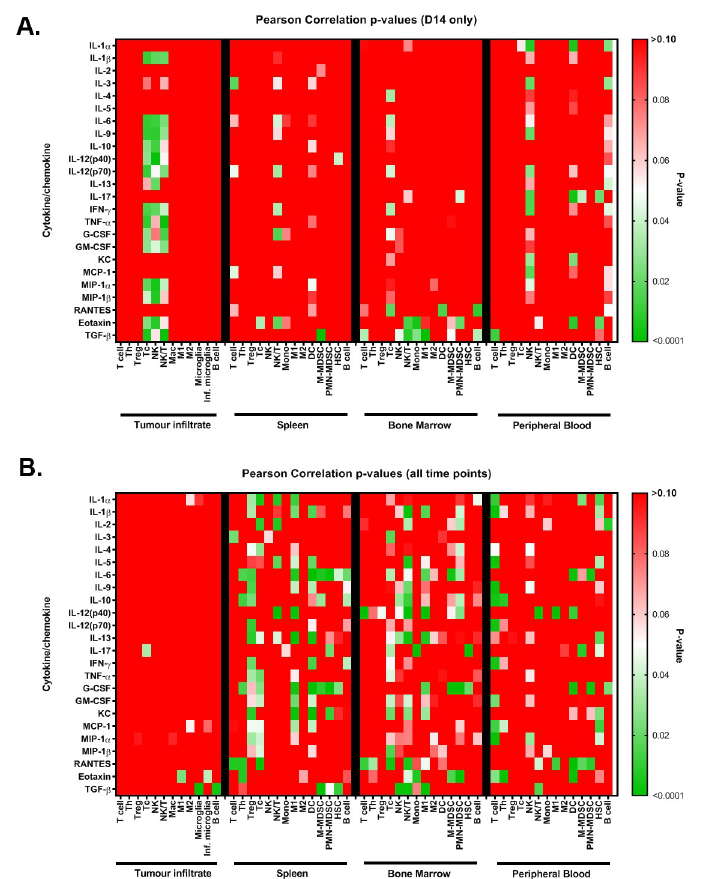
Fig 8. Color maps of the p-values for Pearson correlations between plasma cytokine levels and tumor and systemic immune cell populations at day-14 post-inoculation (A) and at all time points (B). Red, p > 0.05, white p = 0.05, green p <